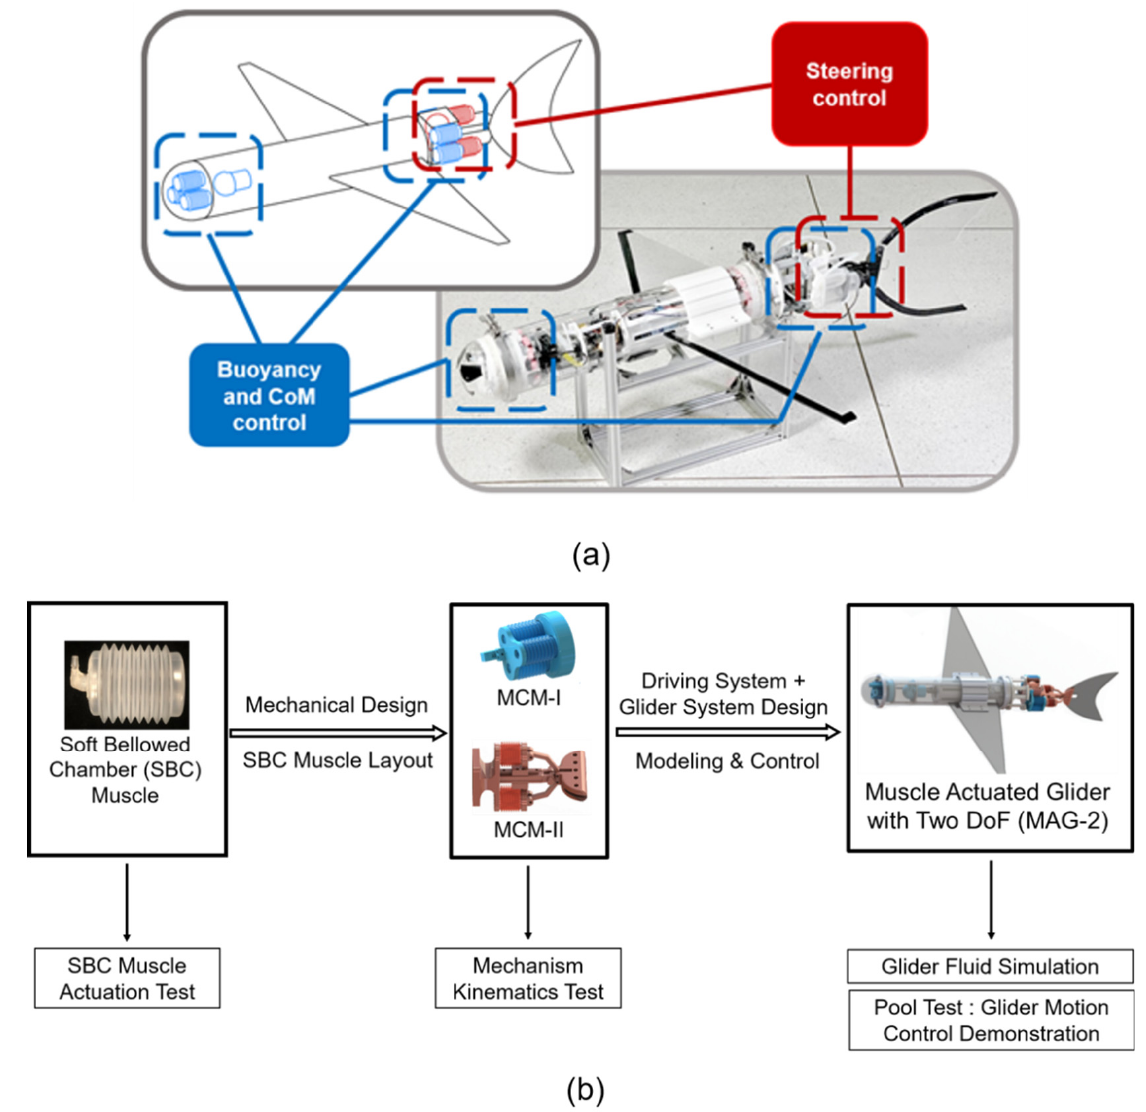
Figure 1. System design concept and research methodology schematic. ( a ) The concept of a modularized design glider coupling the buoyancy with the center of mass control and using a caudal fin to steer. ( b ) Research methodology schematic diagram.